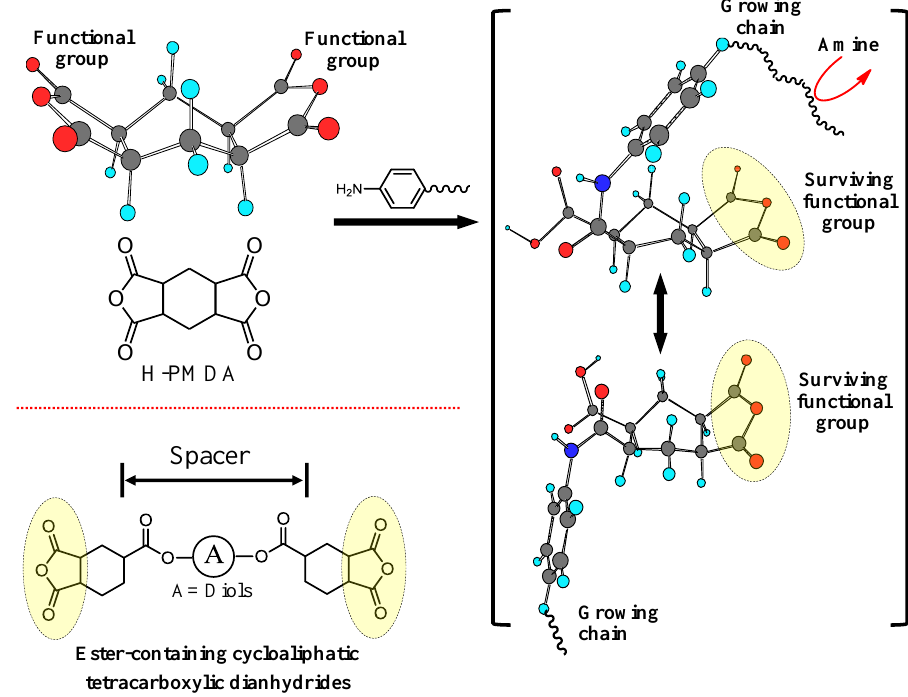
Figure 12. A self-steric hindrance model for explaining the η inh -based H-PMDA polymerizability much lower than that of PMDA and ester-inked HTA-derived cycloaliphatic tetracarboxylic dianhydrides. Reproduced with permission from Elsevier [35].